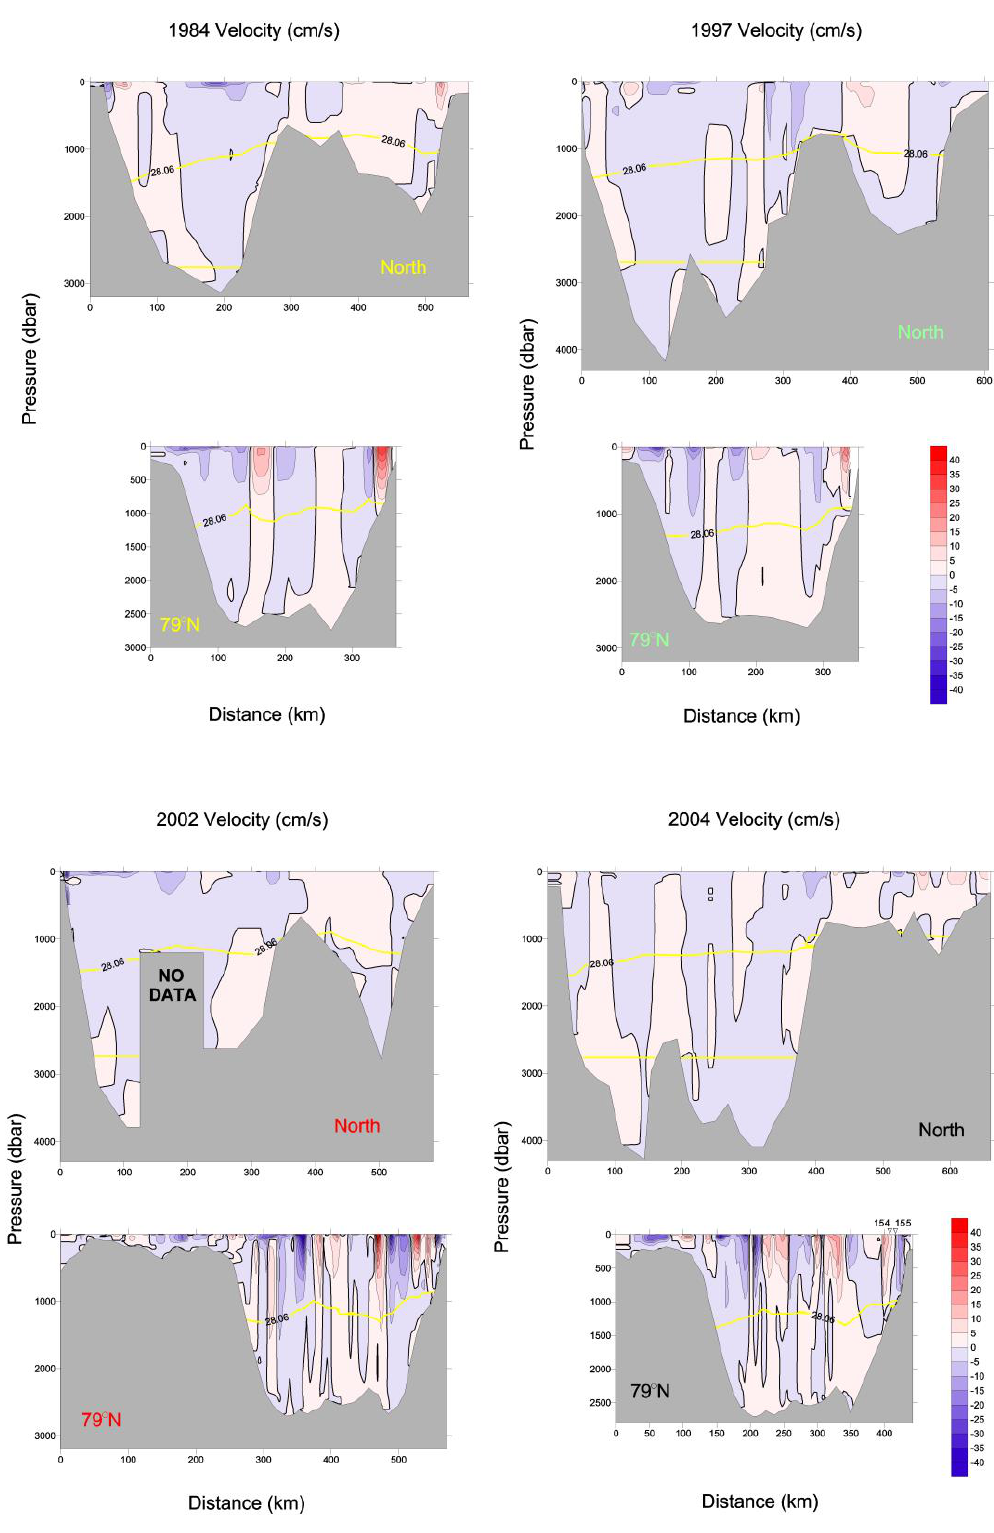
Fig. 3c. (a) Potential temperature, (b) salinity and (c) velocity with constraints applied from the zonal sections in 1984, 1997, 2002 and 2004 (Fig. 2). The constraint boundaries, potential density ( σ θ ) surface 28.06 and the 2744dbar pressure level, are shown (yellow lines). Positive (negative) velocities are northward (southward). Stations 154 and 155 shown in Fig. 6 are marked with arrows in all the 2004 79 ◦ N sections. Colour coding of the sections (North for the northern section, and 79 ◦ N) follows that of Fig.